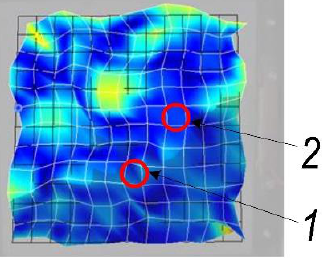
Figure 2. An aluminum alloy sheet vibrations at an excitation frequency of 30 kHz and forming tool contact with a sheet location: 1—bottom; 2—on the side.